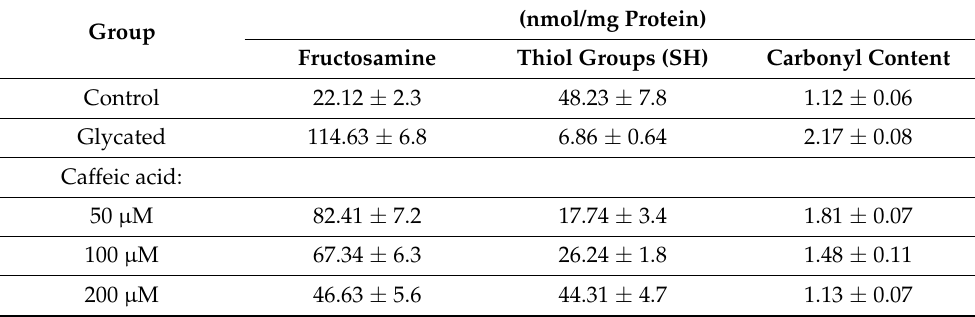
Table 3. Effect of different concentrations of caffeic acid on alpha amylase.